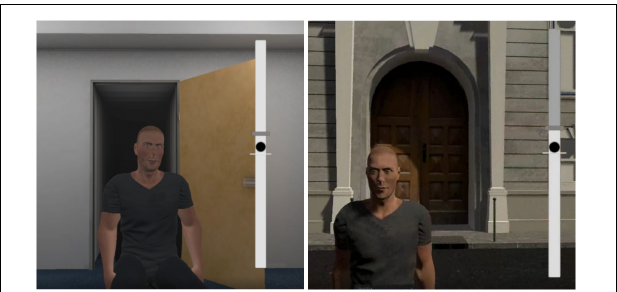
FIGURE 1 | Image captures from the Virtual Reality task in Study 1 (left) and Study 2